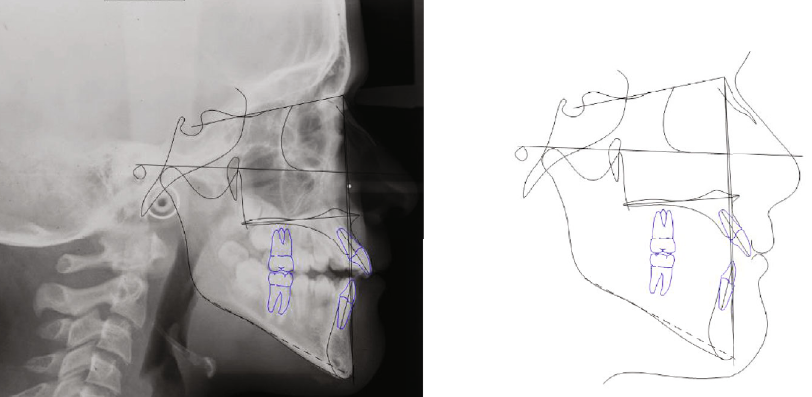
Figure 13: Case no. 2 tracings at T